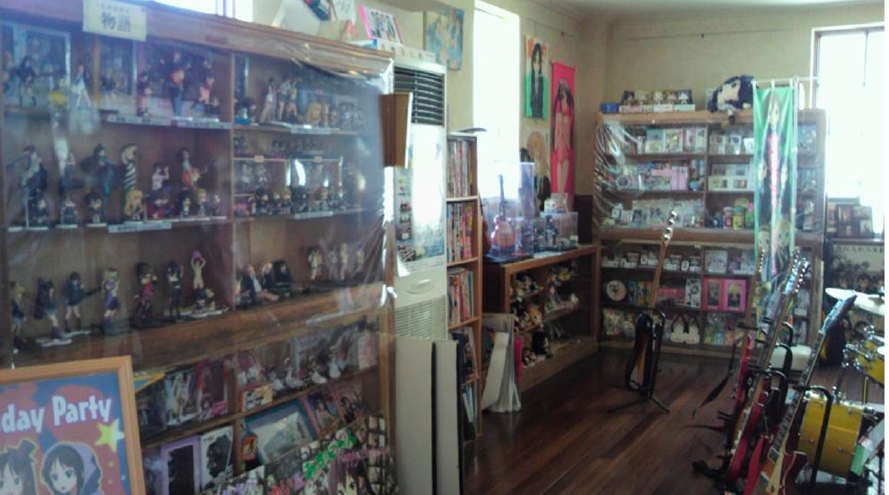
Figure 2. Goods left by anime-induced tourists at Toyosato Town, Shiga, a filming site of the TV anime K-On!